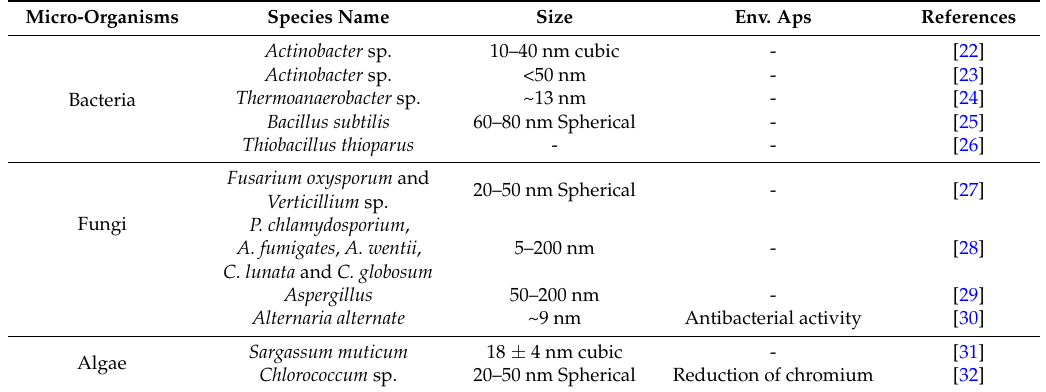
Table 2. Size, morphology and environmental application of Fe 0 /Fe 2 O 3 /Fe 3 O 4 nanoparticles synthesised by